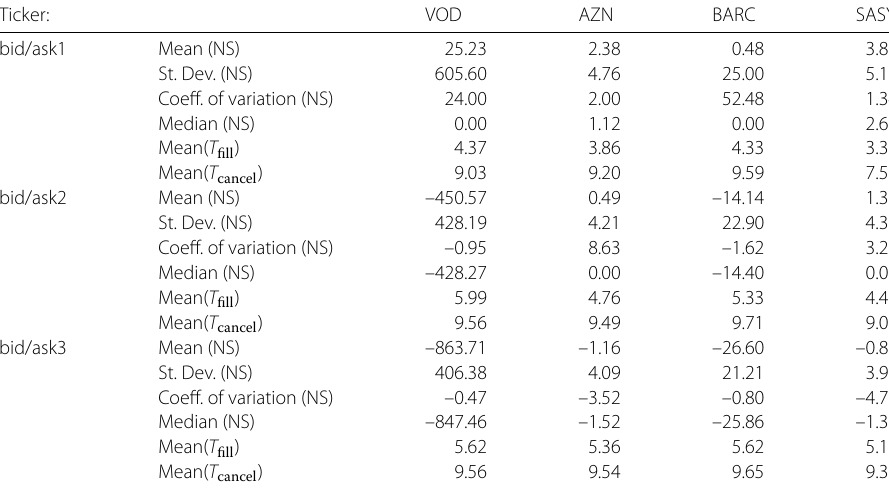
Table 3 Negative Selection statistics and Fill/Cancel average time for BB Ticker: